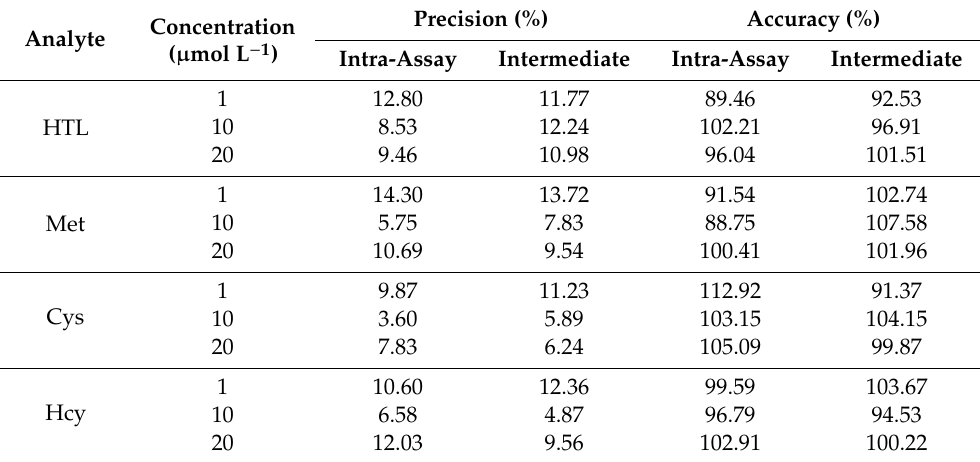
Table 3. Precision and accuracy data ( n =